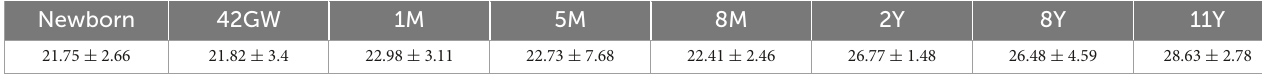
TABLE 3 Average ± SD of the diameter of PV-immunoreactive neurons in the Ammon’s horn in different age-groups.